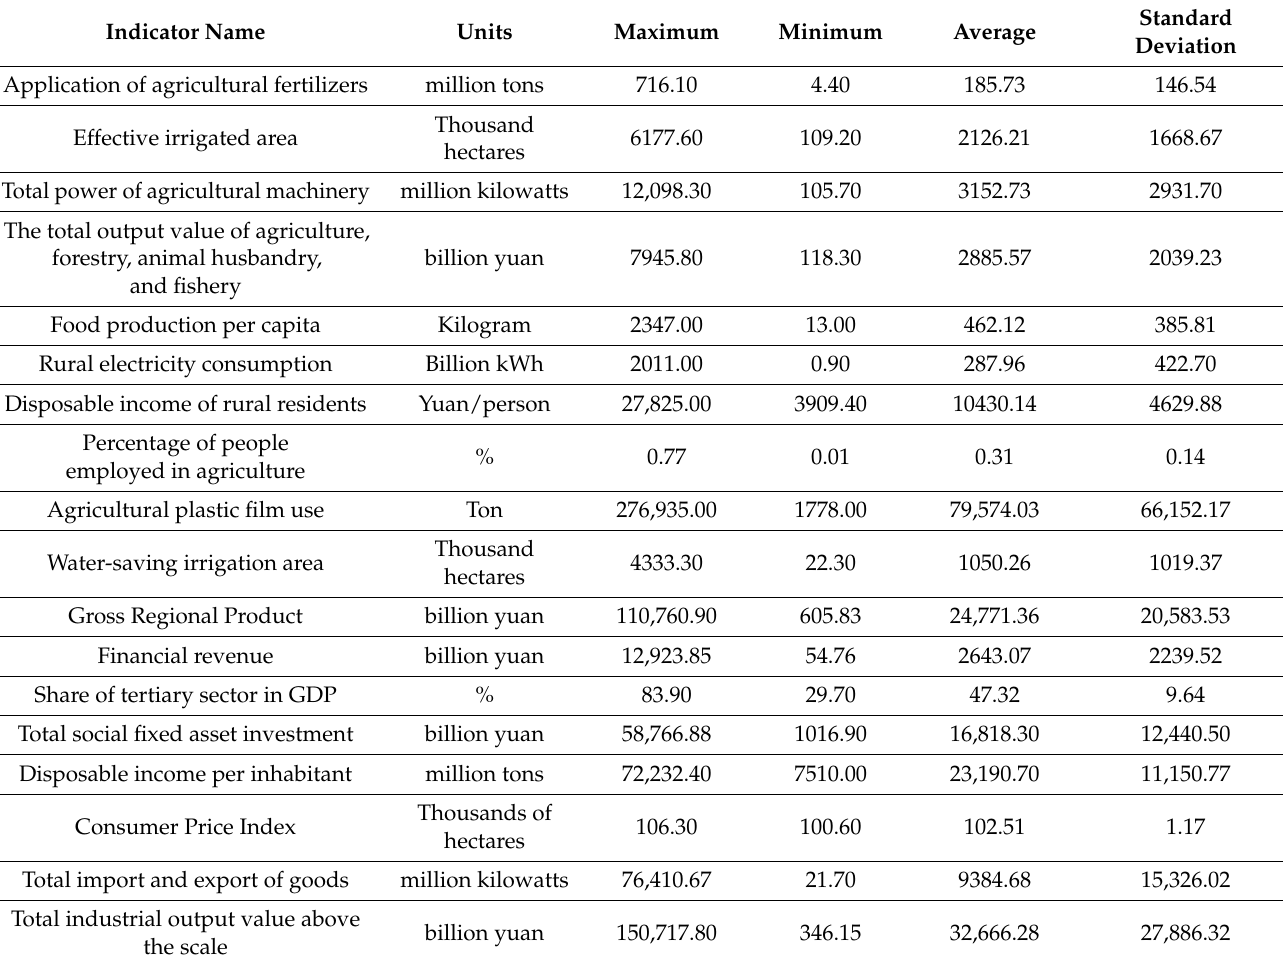
Table A1. Mean basic characteristics of each